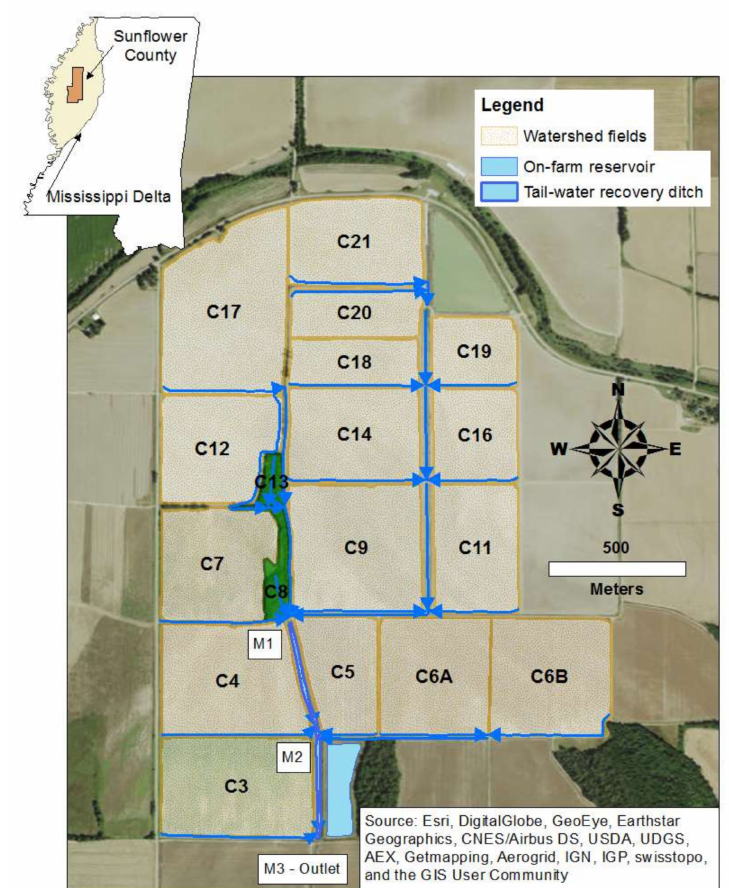
Figure 1. Map of the study area showing the agricultural watershed with the on-farm water storage system investigated in the Mississippi Delta Region. The blue arrows represent the runo ff flow direction towards the outlet. (M1: tailwater recovery (TWR) inlet; M2: TWR mid-canal; M3: TWR outlet; labels within fields indicate the subwatershed identification used by the annualized agricultural non-point source (AnnAGNPS)